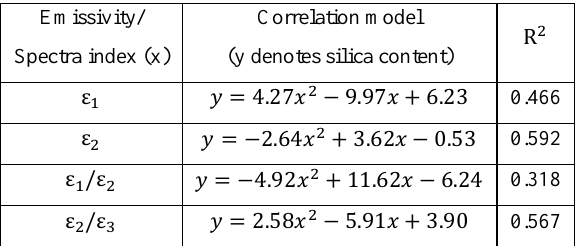
Table 2 Correlation model built for silica content estimate based on GF-5’s TIR band emissivity/spectral